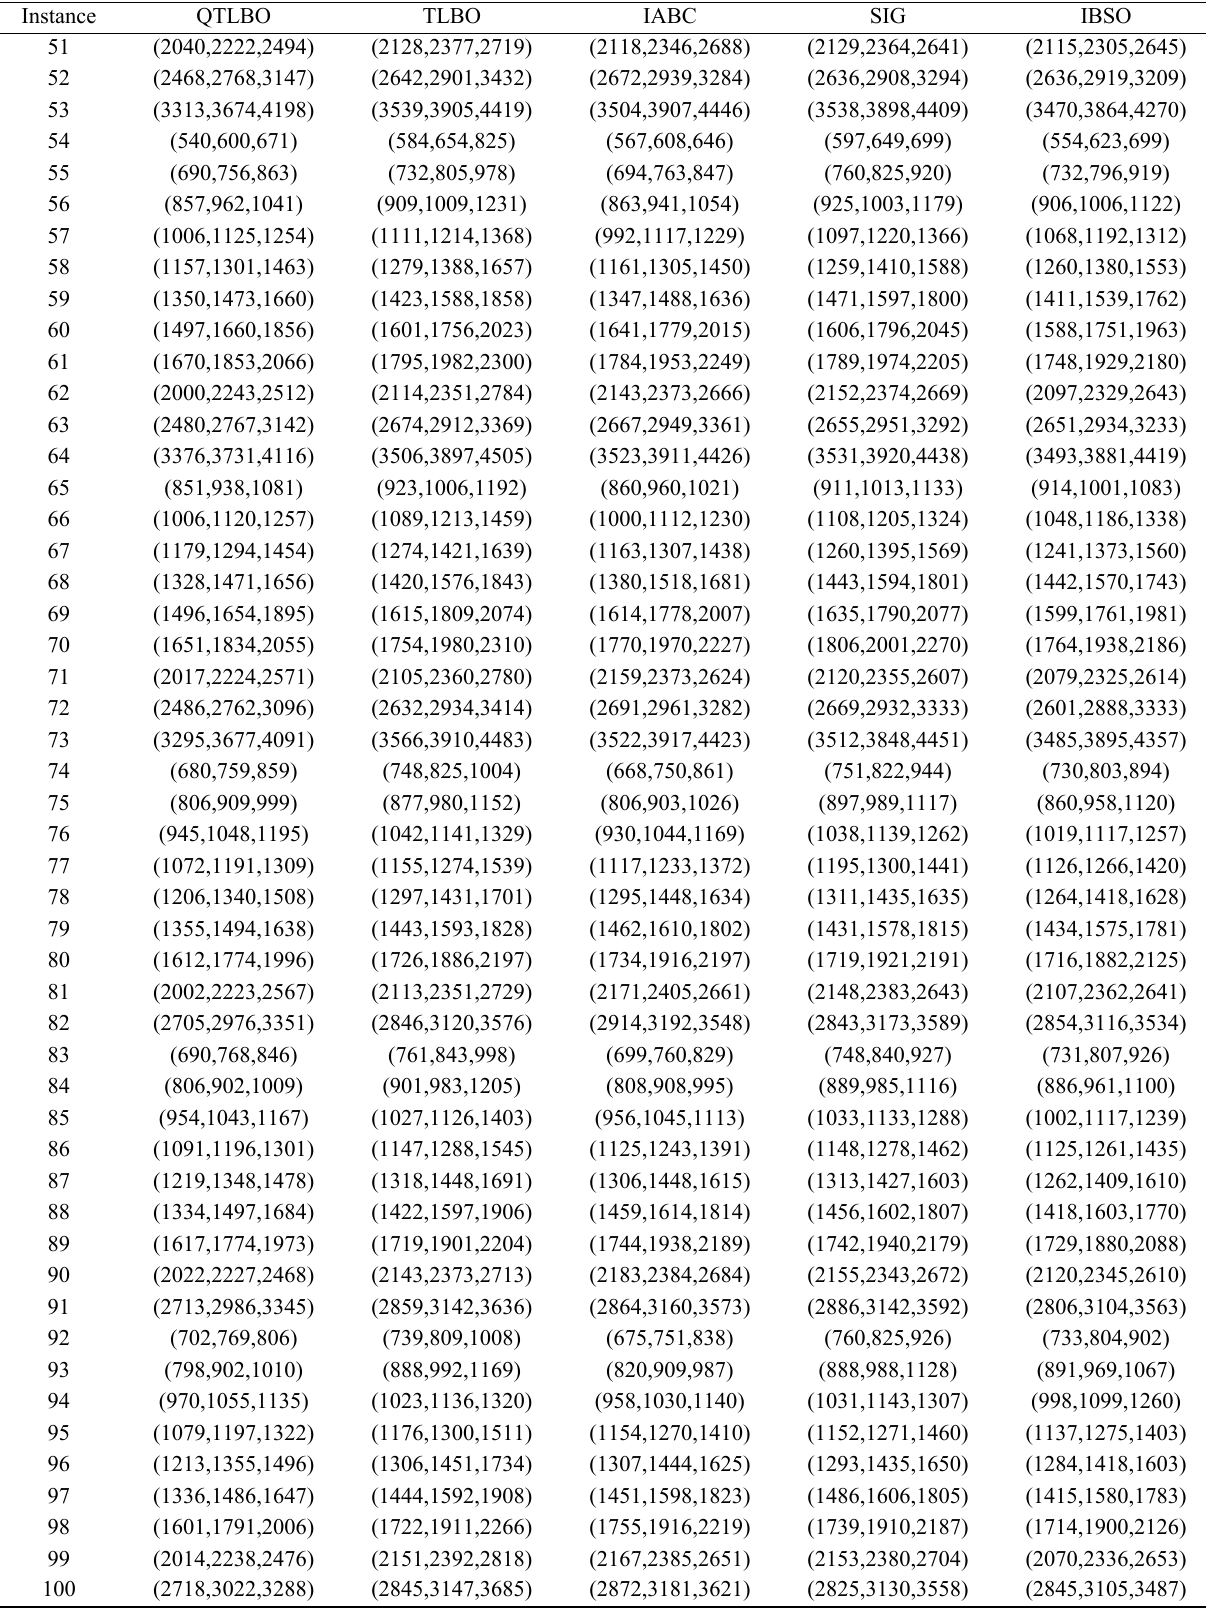
Min Table 8 Computational results of all algorithms on for instances